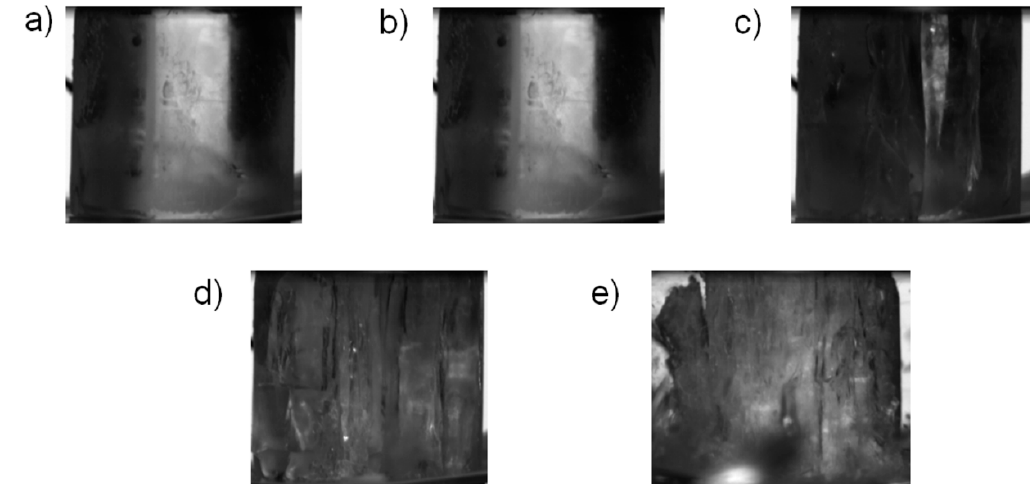
Figure 9. Examples of video frames recorded in the quasi-static test QS_m20_06: ( a ) prior to loading, ( b ) immediately prior to the first drop in load (eng. stress = 10.1 MPa), ( c ) 0.1 s after the previous frame, ( d ) at maximum load (eng. stress 22.7 MPa), and ( e ) 0.1 s after the previous frame (zero load). The full video is provided as supplementary material S4.